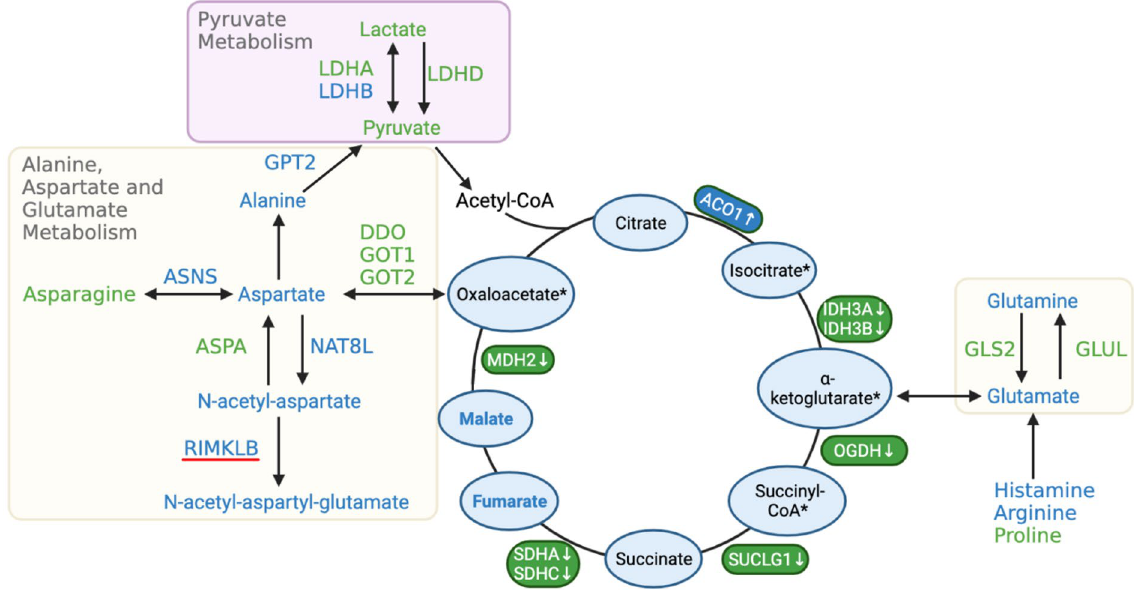
Figure 5. Schematic representation of altered TCA cycle and increase in amino acids involved in anaplerosis in breast muscles affected with wooden breast myopathy. Colors indicate higher (blue), lower (green) and not statistically different (black) abundance of a metabolite or gene transcripts in wooden breast affected p. major muscles in broiler chickens. * Not detected in metabolome data. ACO1 Aconitase 1, nad(+) Isocitrate dehydrogenase, IDH3A, IDH3B 3 catalytic subunit, OGDH Oxoglutarate dehydrogenase, SUCLG1 Succinate-CoA ligase GDP/ADP-forming subunit alpha, SDHA, SDHC Succinate dehydrogenase complex flavoprotein subunit, MDH2 Malate dehydrogenase 2, LDHA, LDHB , LDHD Lactate dehydrogenase, DDO D-aspartate oxidase, GOT1, GOT2 Glutamic-oxaloacetic transaminase. ASNS Asparagine synthetase, ASPA Aspartoacylase, NAT8L N-acetyltransferase 8 like, RIMKLB Ribosomal modification protein rimk like family member, GLUL Glutamate-ammonia ligase, GLS2 Glutaminase 2. This figure was created with BioRender.com (http:// biore nder.